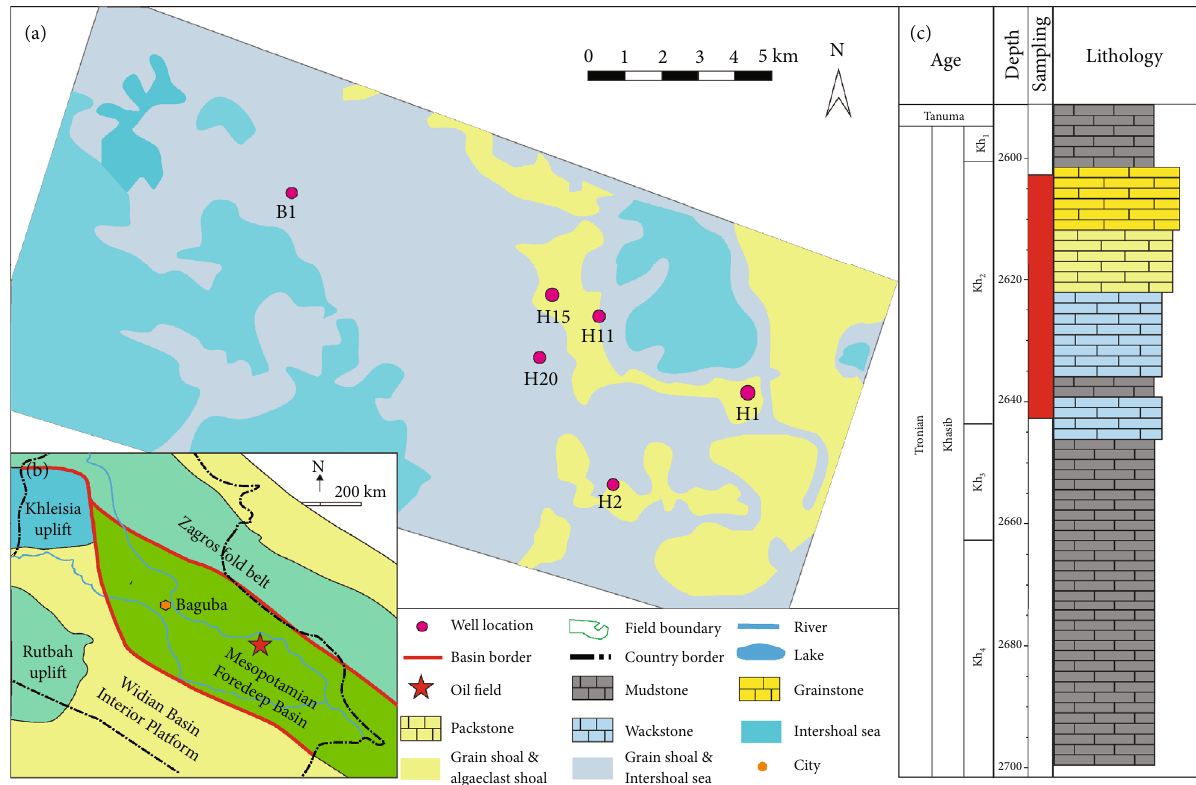
Figure 1: (a) Geographical location map of the H oil fi eld. (b) Regional tectonic map of the H oil fi eld. (c) Column chart of Kh